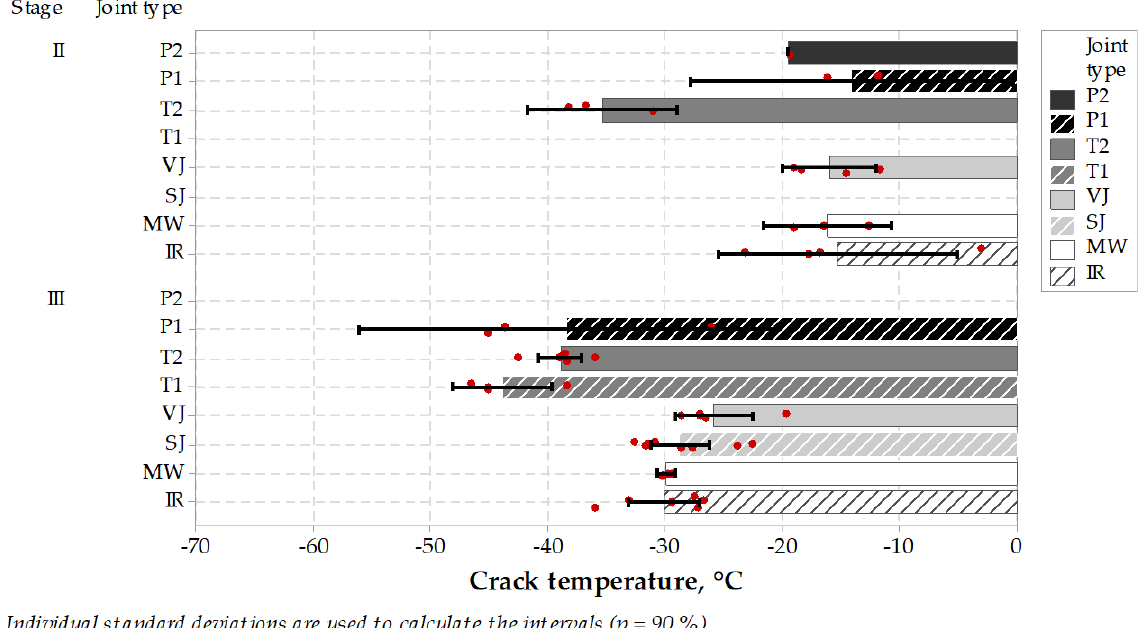
Figure 5. Test results of the maximum stress induced in specimens taken from longitudinal joints (the higher, the better).